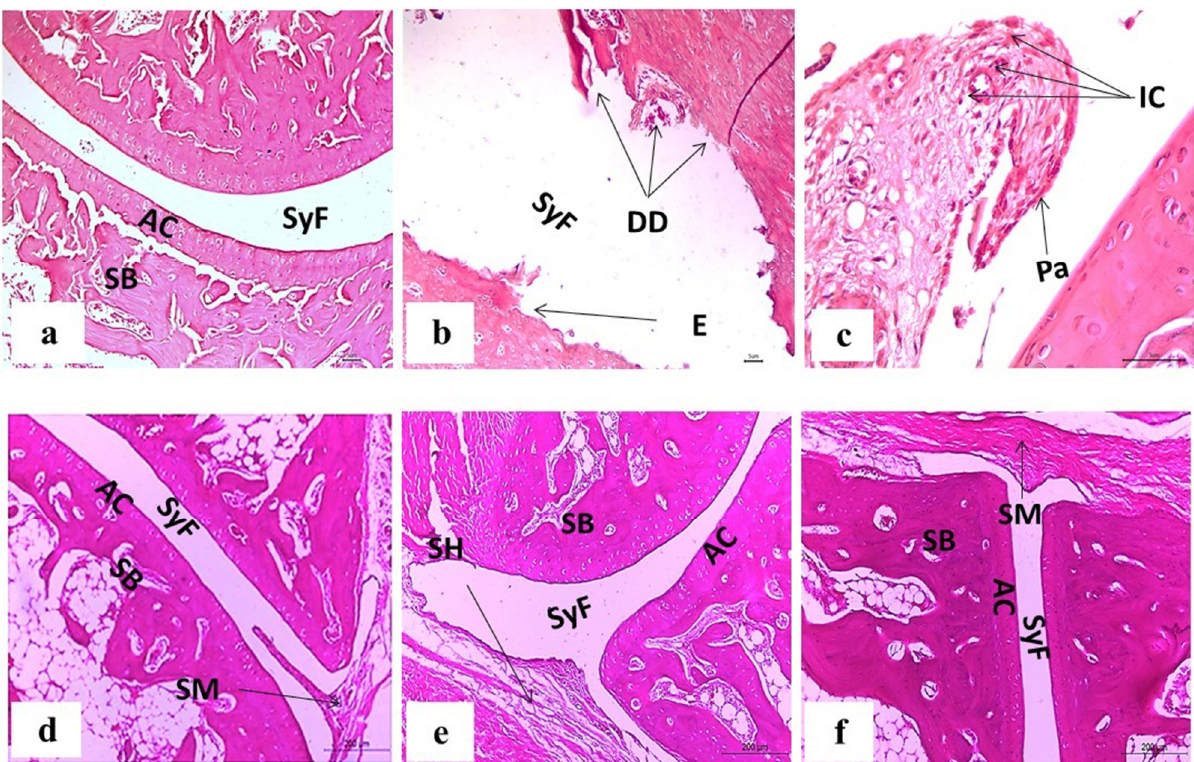
Figure 11. Photomicrographs of H&E-stained sections illustrating the effect of diosmin, trolox, and their combination treatments on the histological alterations in the ankle joints of arthritic rats. ( a ) Normal group. ( b , c ) CFA-induced arthritic group. ( d ) Arthritic rats given diosmin. ( e ) Arthritic rats given trolox. ( f ) Arthritic rats given diosmin and trolox. AC, SB, SyF, DD, E, Pa, IC, SM and SH stand for articular cartilage, sponge bone, synovial fluid, degenerative degradation, erosion, pannus formation, inflammatory cells, synovial membrane, and synovial hyperplasia, respectively.